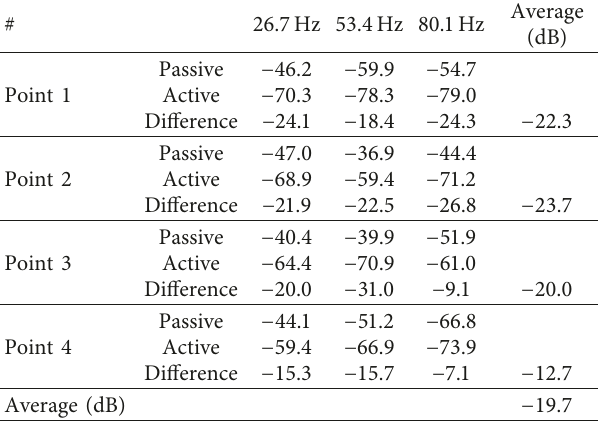
Figure 20: Control results for a 7-DOF system with hybrid mount. (a) Pt. #1, dB dB ref 1g. (cid:30) Table 10: Control results for a 7-DOF system with the hybrid